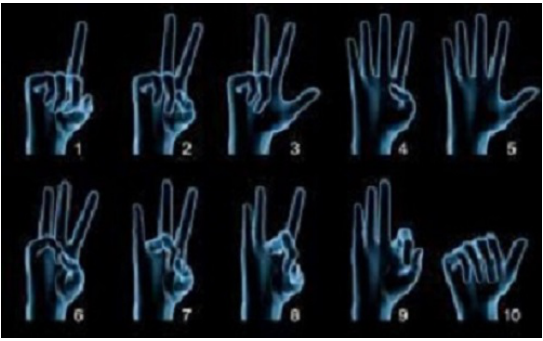
Figure 1. Indian Sign Language